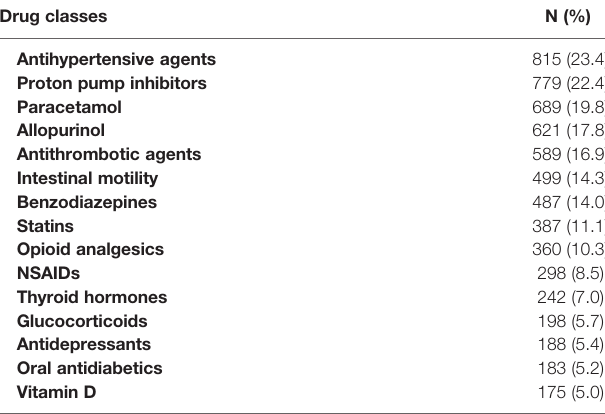
TABLE 3 | Description of drug classes concomitant with TKI exposure (issued within the month of fi rst TKI prescription) in the 3480 incident “ CML ” subjects with at least 2 dispensations of TKI, 2011-2014,